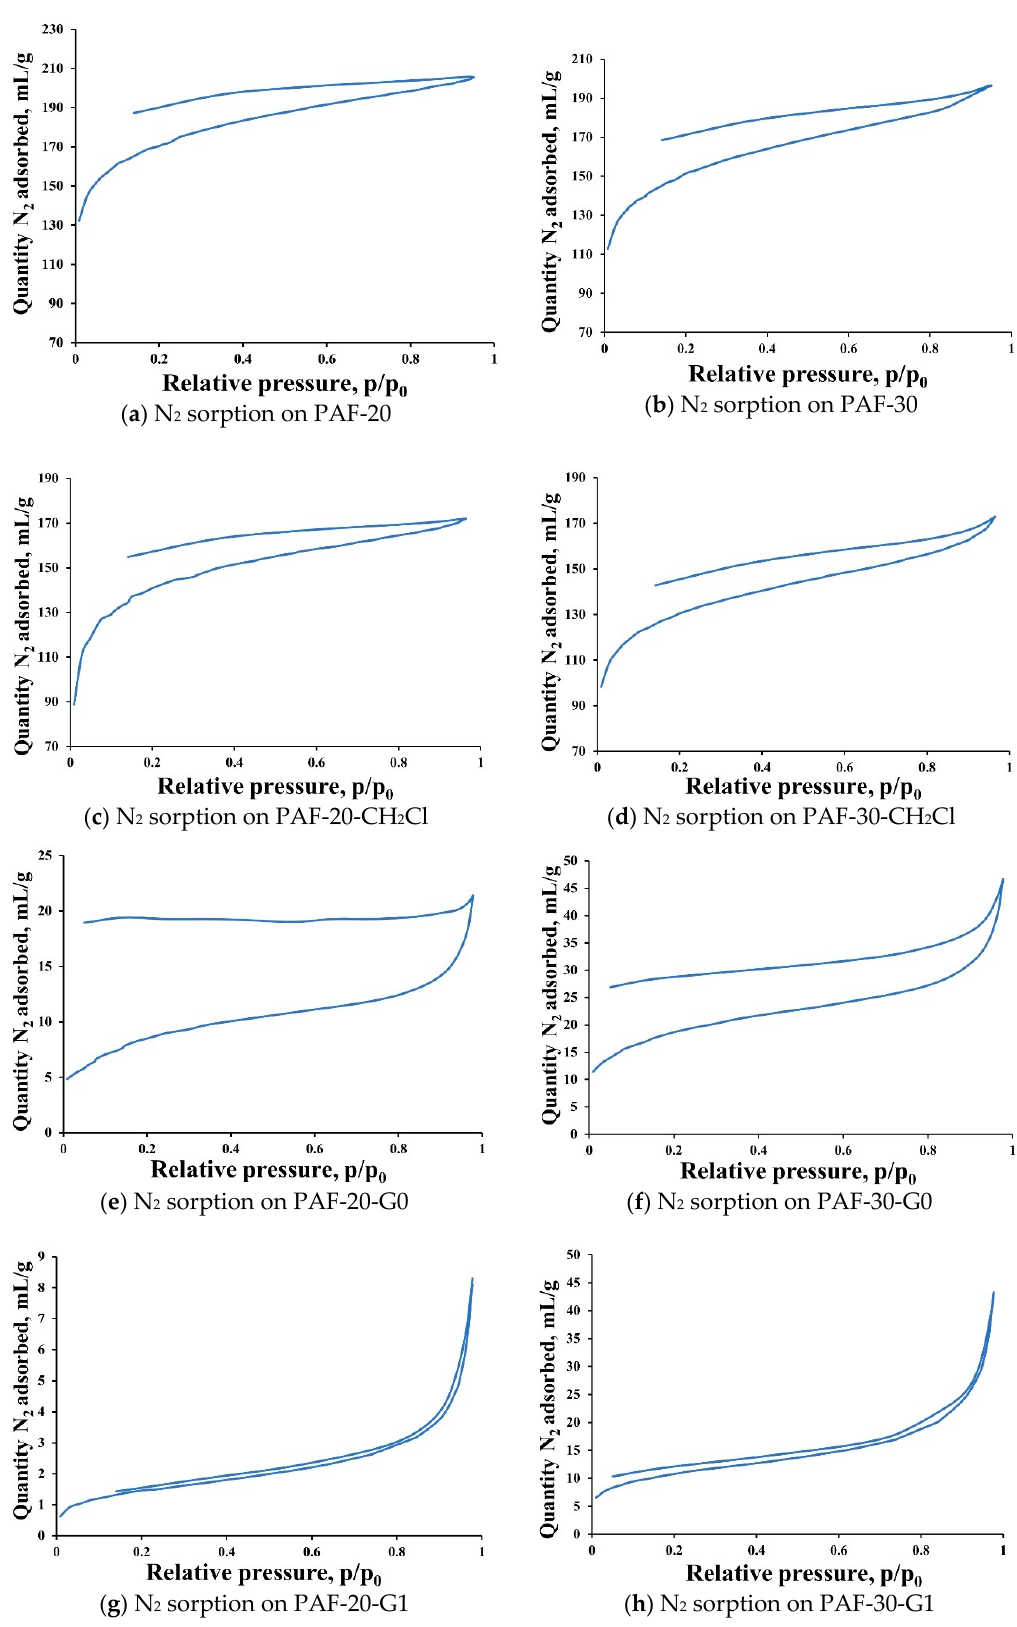
Figure 2. Low-temperature N 2 adsorption on PAF-based materials. Table 1. Results of low-temperature nitrogen adsorption-desorption for obtained materials.